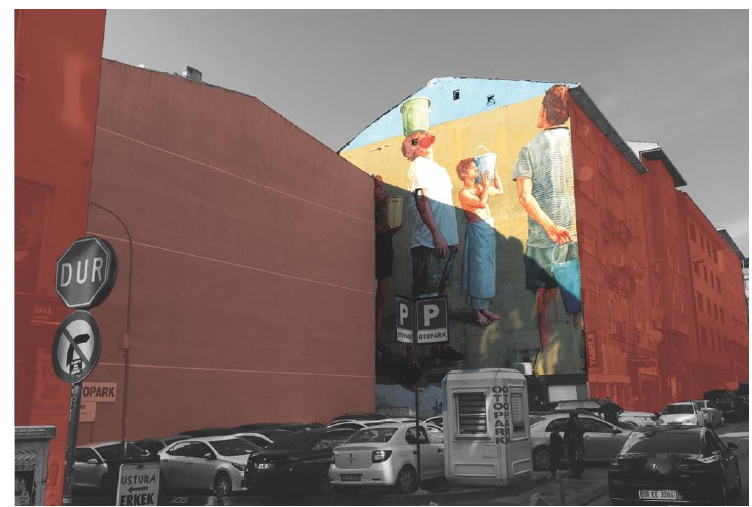
Figure 16 The blind facade of the building on a street wall creates a perceivable contrast within the streetscape. The nearby positioning of the mural takes advantage of that position for the desired perceptional capacity of the public art.